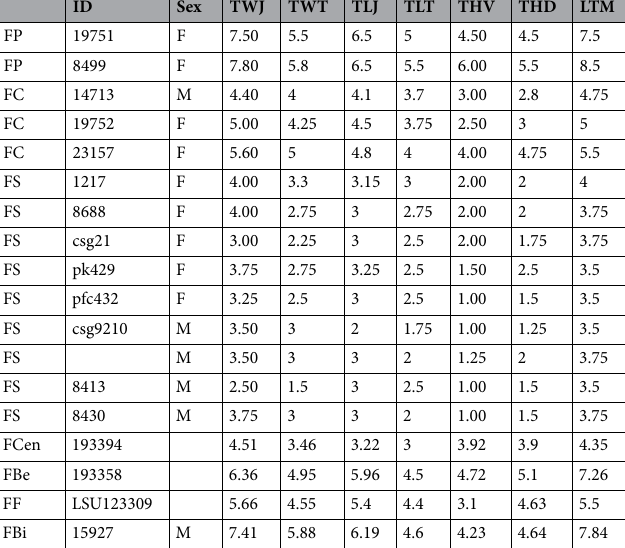
Table 2. Syringeal measurements (mm) of F. peregrinus (FP), F. columbarius (FC), F. sparverius (FS), F. cenchroides (FCen), F. berigora (FBe), F. femoralis (FF), and F. biarmicus (FBi). TWJ = posterior tympanum width, TLJ = posterior tympanum depth; TWT = anterior tympanum width, TLT= anterior tympanum depth; THD and THV = medial height of the tympanum dorsally and ventrally; LTM = width of lateral tympaniform membrane.